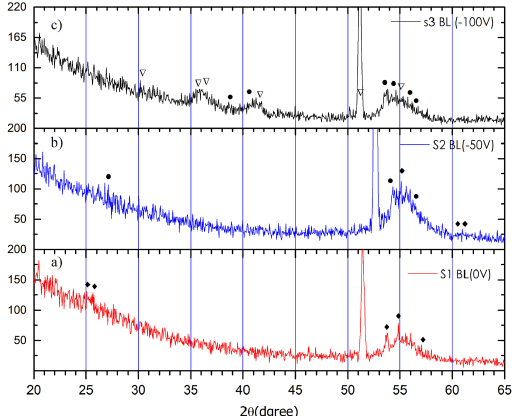
Figure 5. GIXRD spectra of blocking layers deposited with a) 0 V b) -50 V, c) -100 V bias. ♦ -Anatase phase; • - Rutile phase; and - titanium oxide tetragonal phase. ∇